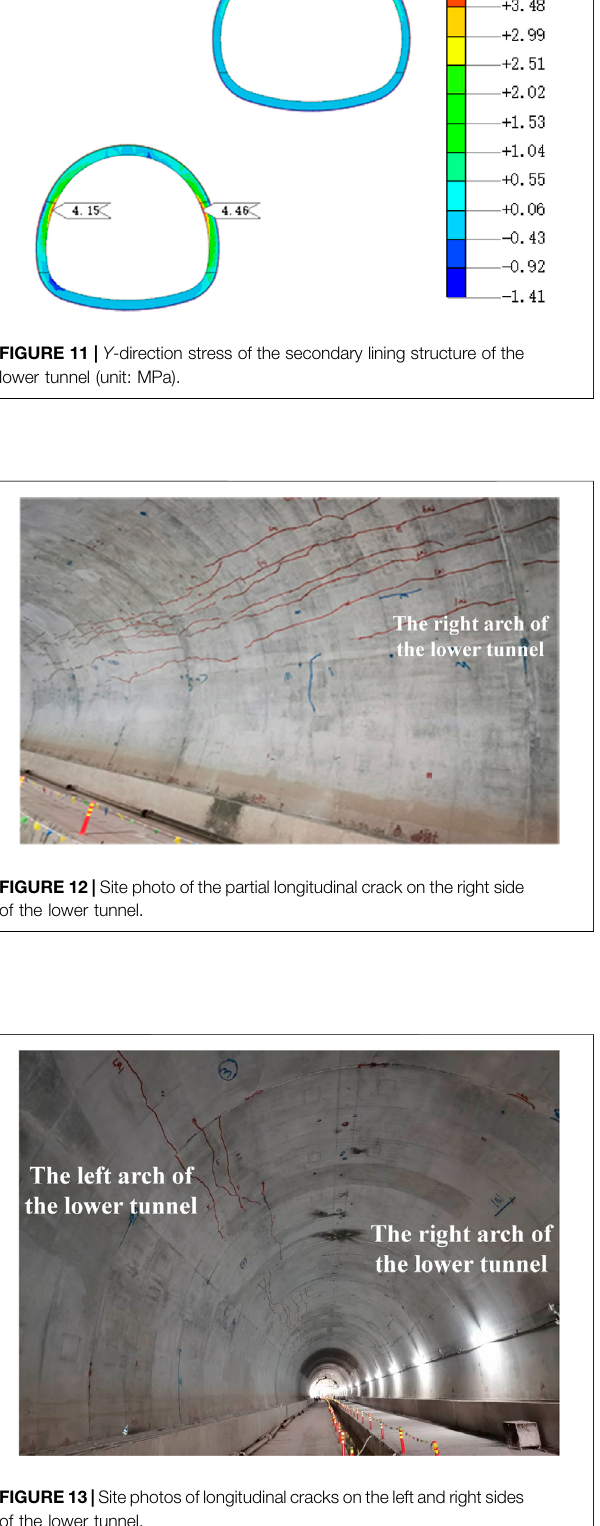
Frontiers in Earth Science |